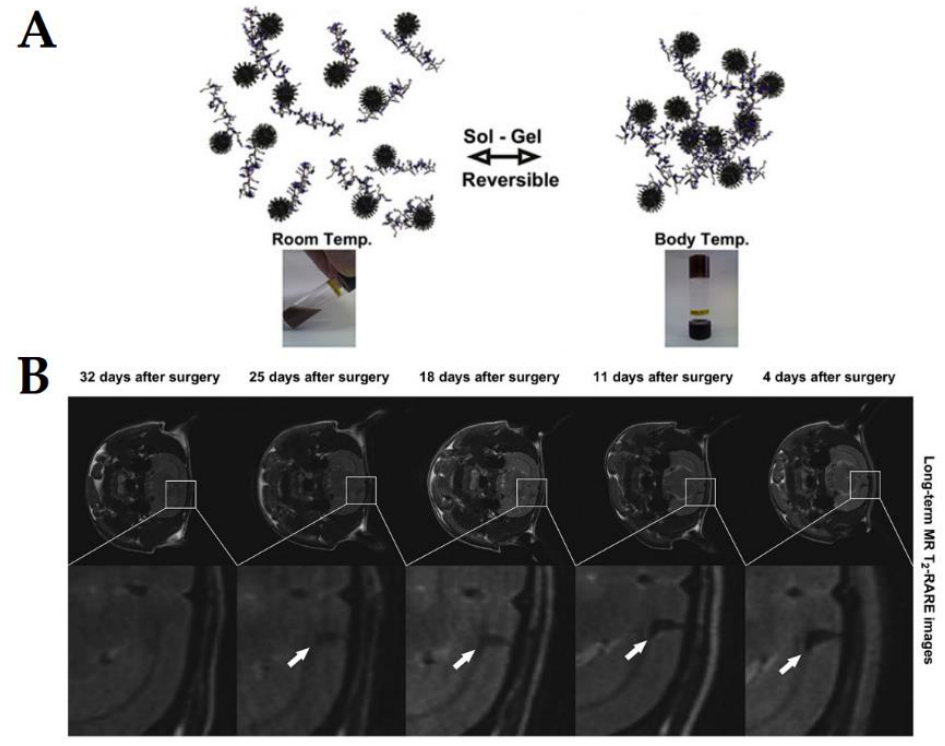
Figure 8. ( A ) Schematic representation of the thermosensitive responsive behavior of the poly(organophosphazene) and cobalt ferrite nanoparticles based magnetogel; ( B ) Time evolution of the in vivo degradation of the magnetogel for the assessment as a long-term MR contrast agent, having been injected into the righthand side of the frontal cortex region of the rat brain near the corpus callosum. Reprinted from [41] with permission from Elsevier, 2012.